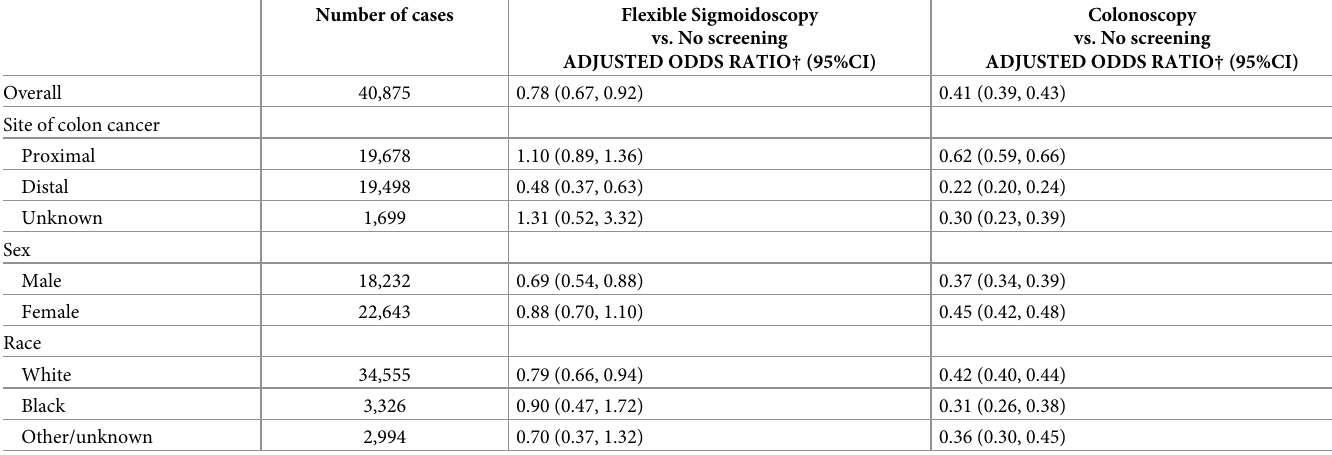
Table 3. Association of screening/surveillance colonoscopy or flexible sigmoidoscopy with colorectal cancer incidence overall and stratified by selected variables, SEER-Medicare � . Number of